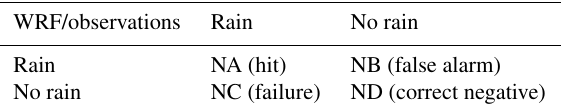
Table 4. Rain–no rain contingency table for the WRF simulation against